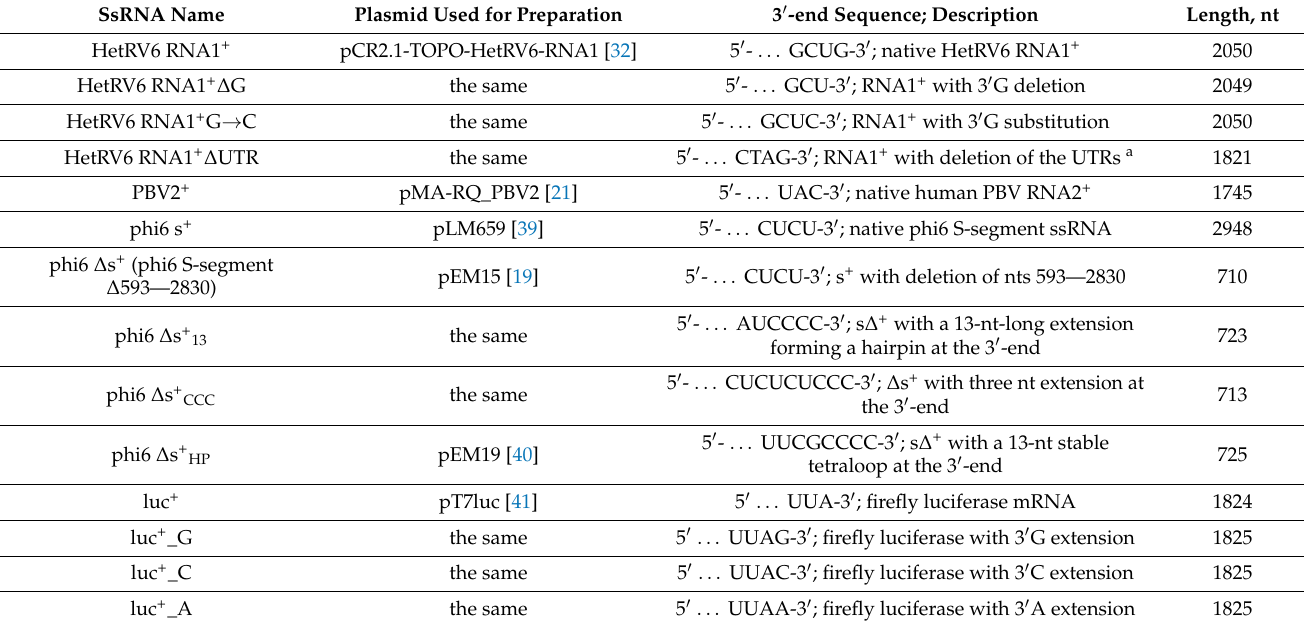
Table 1. SsRNA templates used in the polymerase